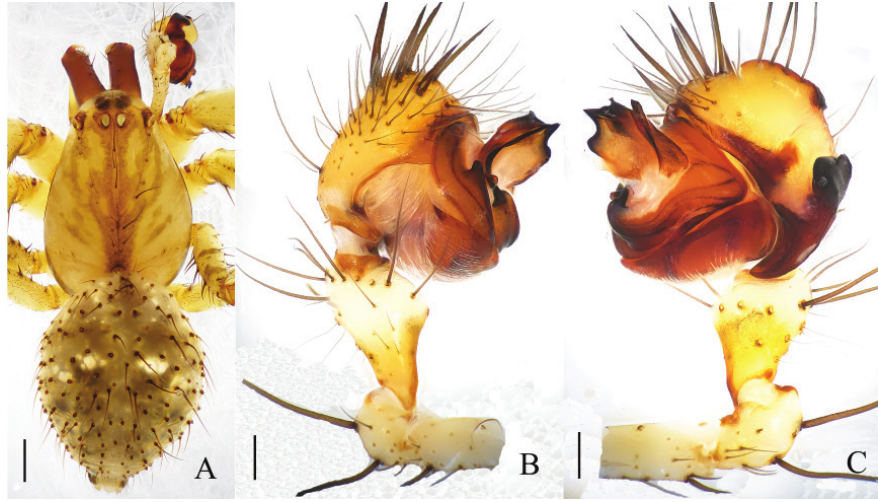
Figure 1. Mimetus echinatus Wang, 1990, one of the males. A habitus, dorsal view B palp, prolateral view C palp, retrolateral view. Scale bars: A , 1.0; B–C , 0.2.